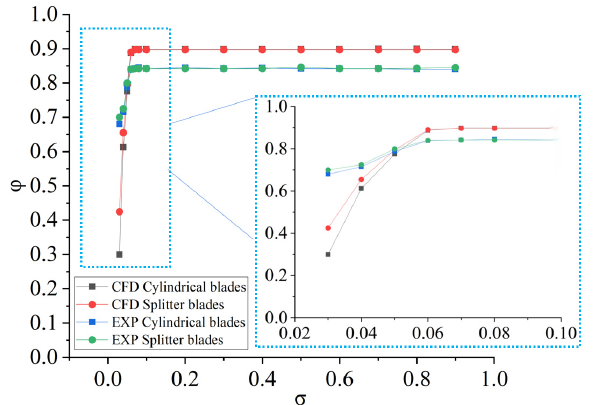
Figure 7. Cavitation curves of the pressure head coefficients of two impellers from simulation and experiment.